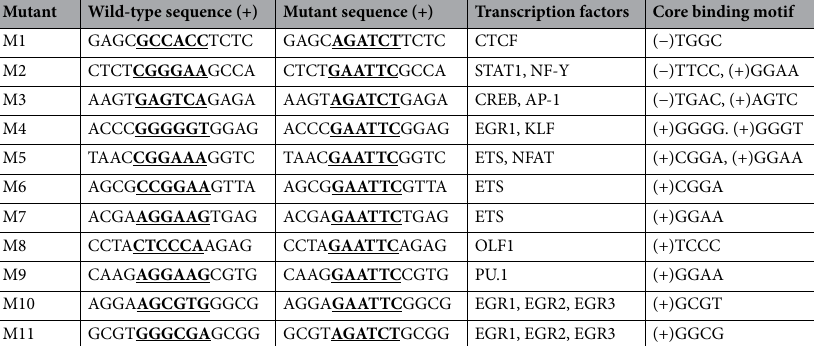
Table 1. Mutant promoters of NME1 and corresponding wild-type sequence, mutant sequence, and transcription factors. Mutants M1 to M7 are located in the proximal promoter region of NME1 between − 244 to − 109 bp, whereas mutants M8 to M11 reside in the minimal promoter region from − 109 to − 1 bp. All wild-type sequences are mutated to either the EcoRI (GAA TTC ) or BglII (AGA TCT ) sequence. Transcription factor interactions are predicted by MatInspector and TRANSFAC. Core binding motifs of corresponding transcription factors are shown at the positive strand (+) or negative strand (−).